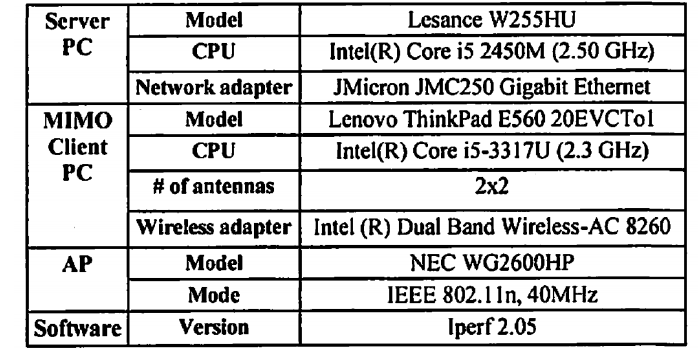
Figure 3. Example of a target printed